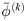
Coherent chaos along multiple modes.(A) Schematic of network with three coherent modes displaying effective output modes, ν(k), and input modes, ξ(k), each of which are orthogonal to all others. (B) Matrix of Pearson correlation coefficients between firing rates, ϕi, of pairs of neurons in a network with three coherent modes and J1 = 1. (C) Sample activity trace displaying sample single neuron activities and in thicker lines, three coherent mode activities, ϕ¯(k). (D) Generalized coherence, χ(k), as a function of J1 for 2,3,4 modes in the regime of passive coherence. Dashed line displays theory. (E) Sample activity traces display extreme coherence for two coherent modes. (F) Generalized coherence for two coherent modes with row balance random connectivity (in blue) as a function of J1 extends to near complete coherence, while chaos persists. Compare network with one coherent mode (in black dashed line). Bar shows standard deviation over 100 realizations. For panels (B), (C), (E)
N = 2000. For panels (D) and (F)
N = 4096.